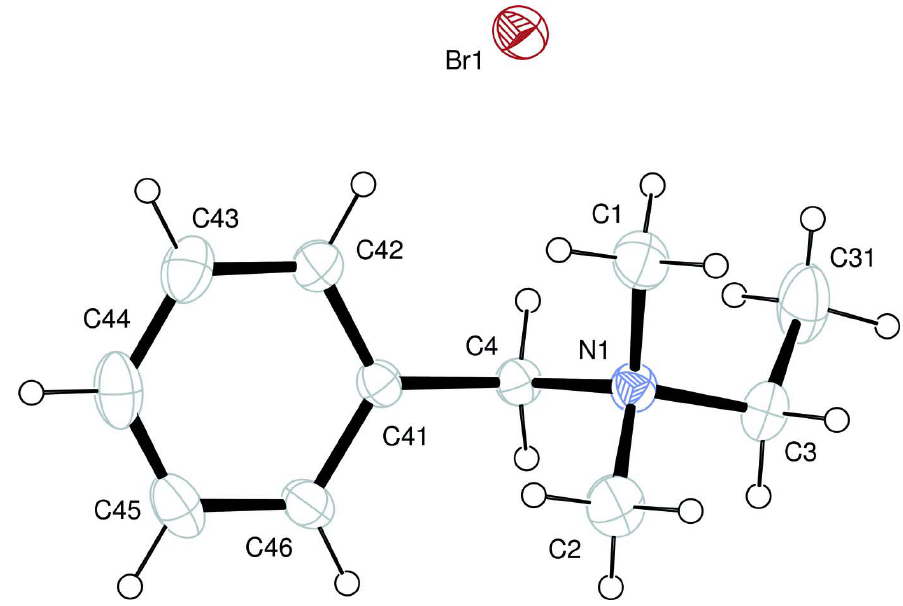
Figure 1 ORTEP - 3 (Farrugia, 1997) drawing of the asymmetric unit with atom labels. Displacement ellipsoids of non-H atoms are drawn at the 30% probabilty level.